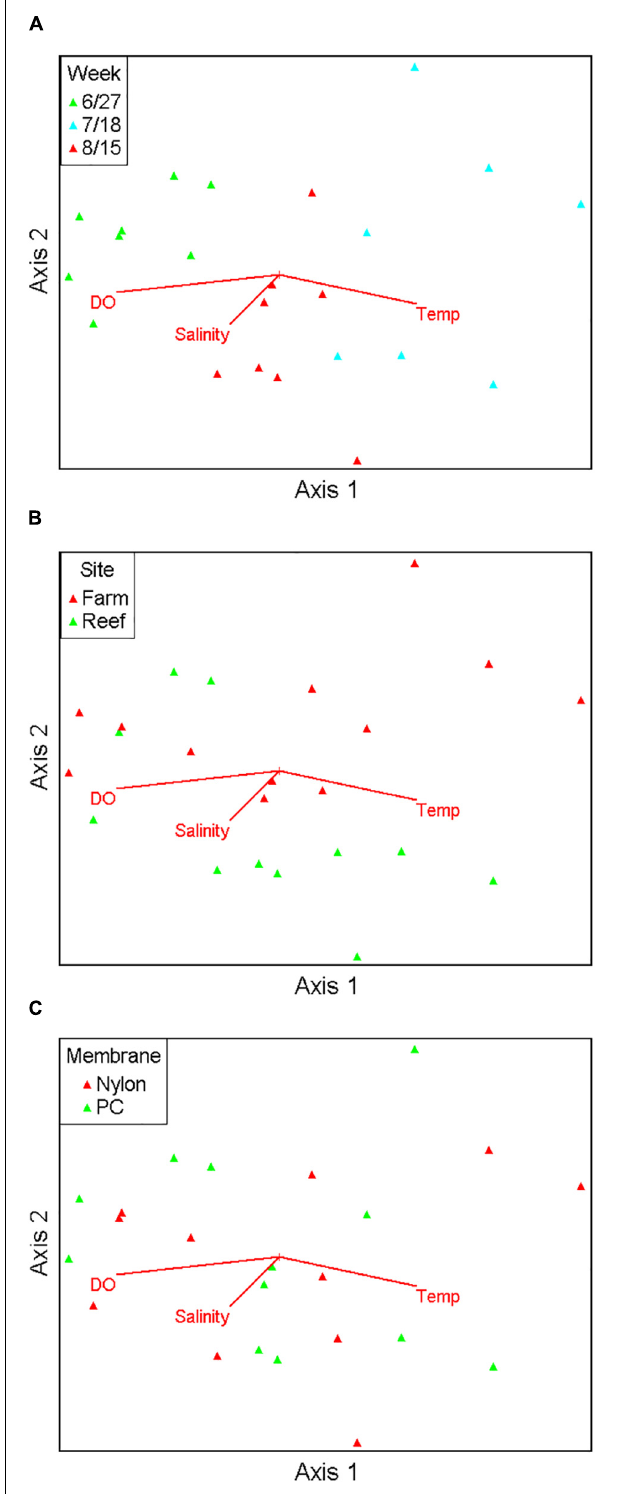
FIGURE 3 | Non-metric multidimensional scaling ordination comprising 17 major fish taxa viewed as biplots grouped by sampling month (A) , site (B) , and filter type (C) , with numerical environmental parameters superimposed as vectors.